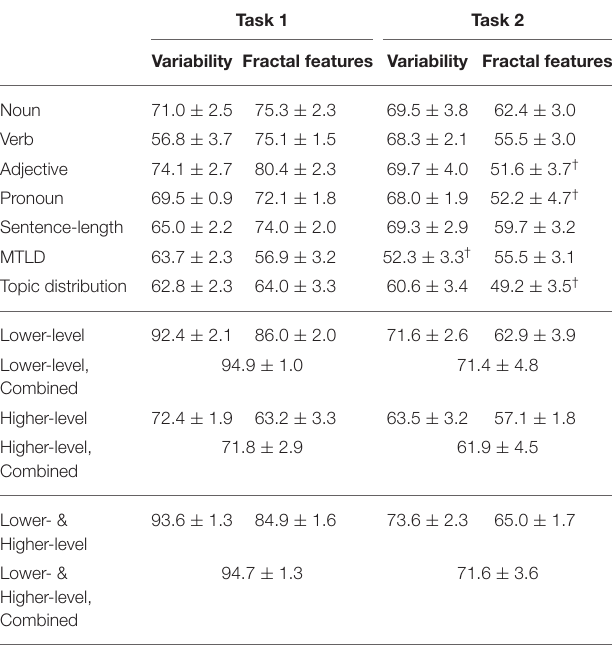
TABLE 3 | Accuracy of classification (in %) for the non-fictional/fictional distinction (Task 1) and the canonical/non-canonical distinction (Task 2). Task 1 Task